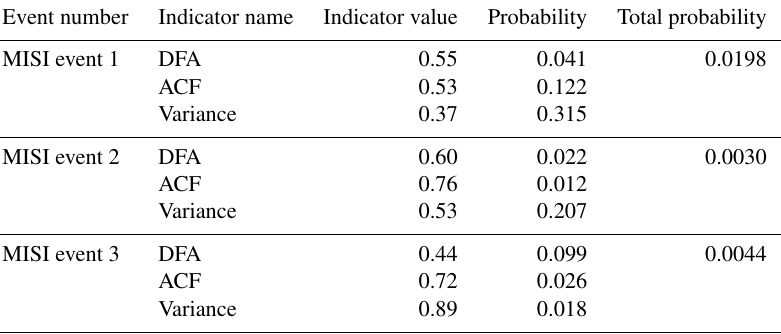
Table 1. Probability of Kendall’s τ correlation for each indicator being a result of chance. A total of 1000 surrogate time series of the state variable are generated, and the indicators and Kendall’s τ correlations are calculated for each one. The probability of Kendall’s τ value is then the fraction of these surrogate time series with a higher correlation coefficient. The total probability is the fraction of surrogates for which all three indicators have a higher correlation coefficient than is observed in the original model time